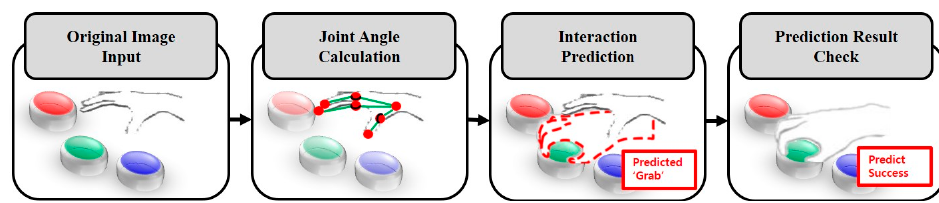
Figure 7. Interaction prediction procedure of the proposed method.